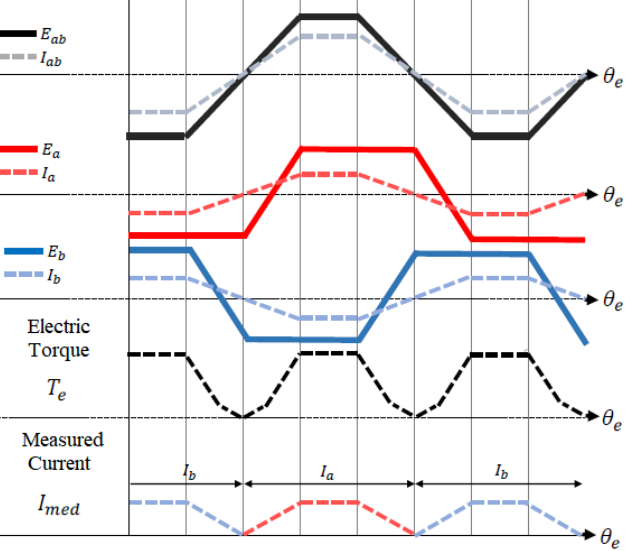
Figure 6. Numerical simulation of a BLDC motor under fault in phase c in 180 ◦ Six-Step operation mode using the current reduction strategy.